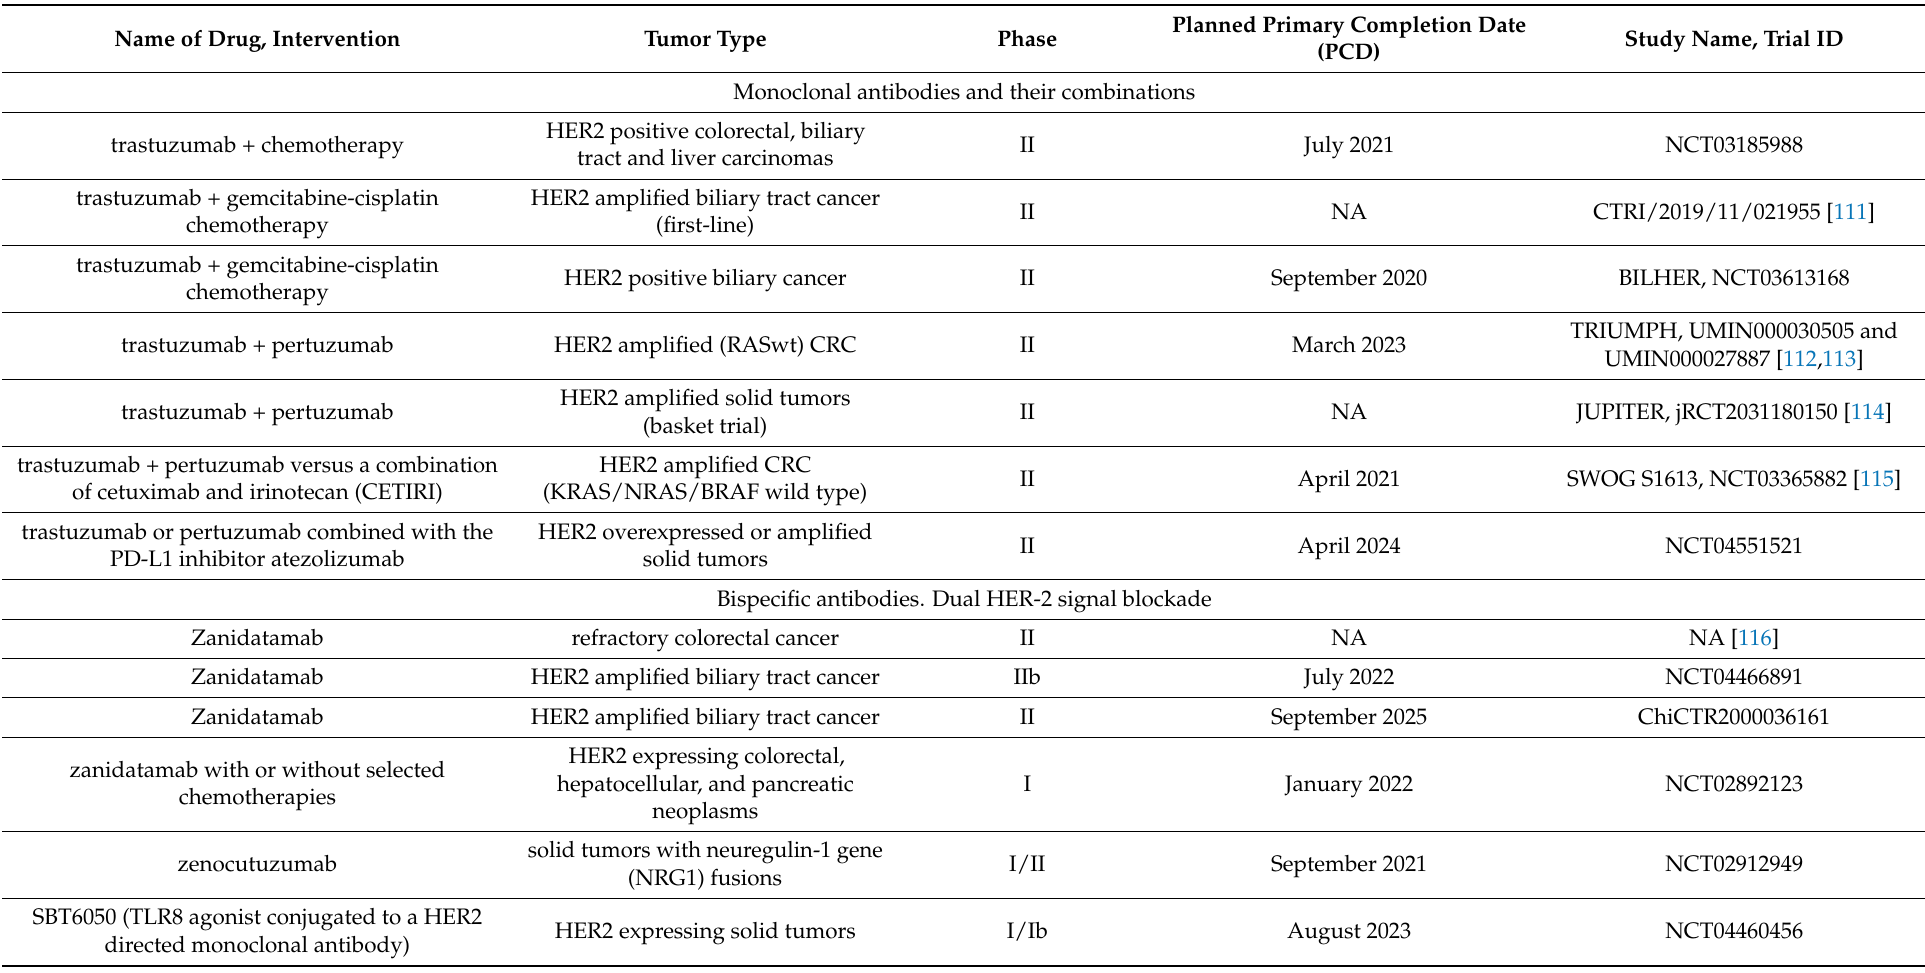
Table 3. Ongoing trials using anti-HER2 agents in gastrointestinal